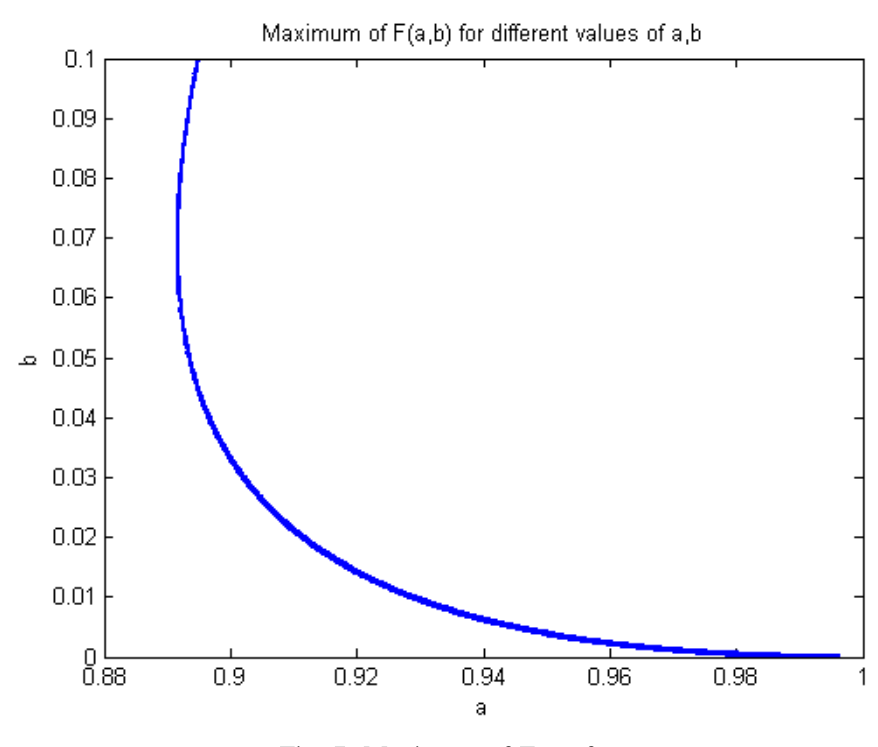
Fig. 7: Maximum of Fano